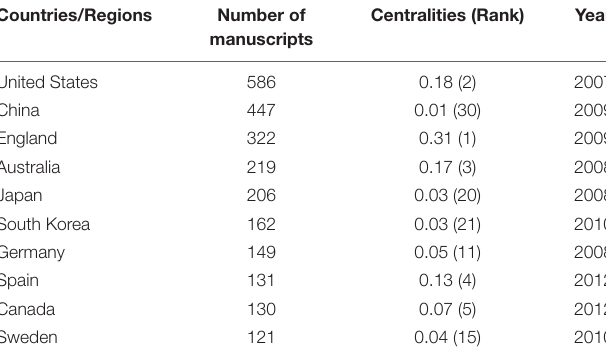
TABLE 2 | The top 10 countries and regions in terms of